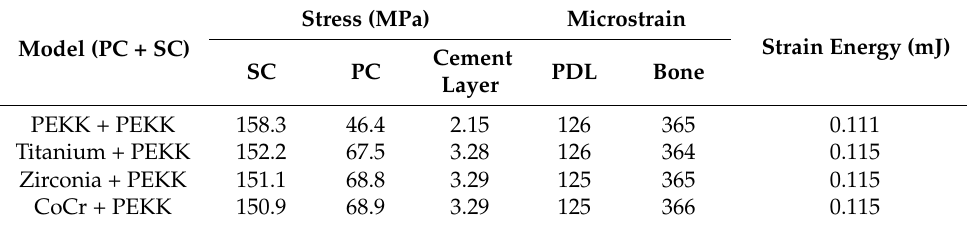
Strain Energy (mJ)